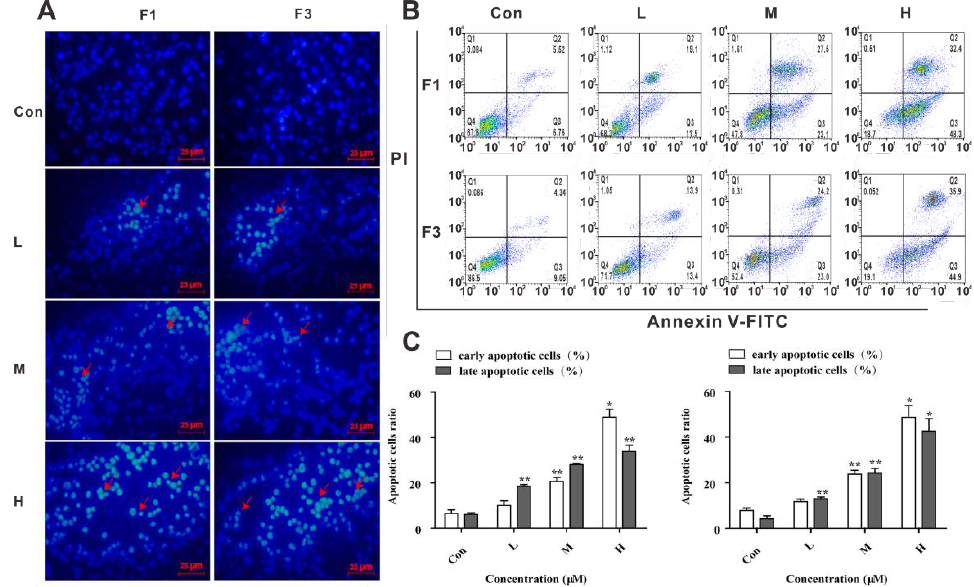
Figure 2. F1 and F3 induced apoptosis of Jurkat cells. ( A ) The morphological changes in Jurkat cells treated with F1 (F1-L: 10 µM, F1-M: 20 µM, F1-H: 40 µM) or F3 (F3-L: 15 µM, F3-M: 30 µM, F3-H: 50 µM) were determined by Hoechst 33258 staining (Scale bar =25 µm, 400×). ( B ) Effects of F1 or F3 at different concentrations for 48 h on the apoptosis of Jurkat cells were detected by the flow cytometer. ( C ) The sum of early and late apoptotic cells ratio was calculated. The data were shown as mean ± SEM of three independent experiments; * p < 0.05 and ** p < 0.01 vs. the control group.